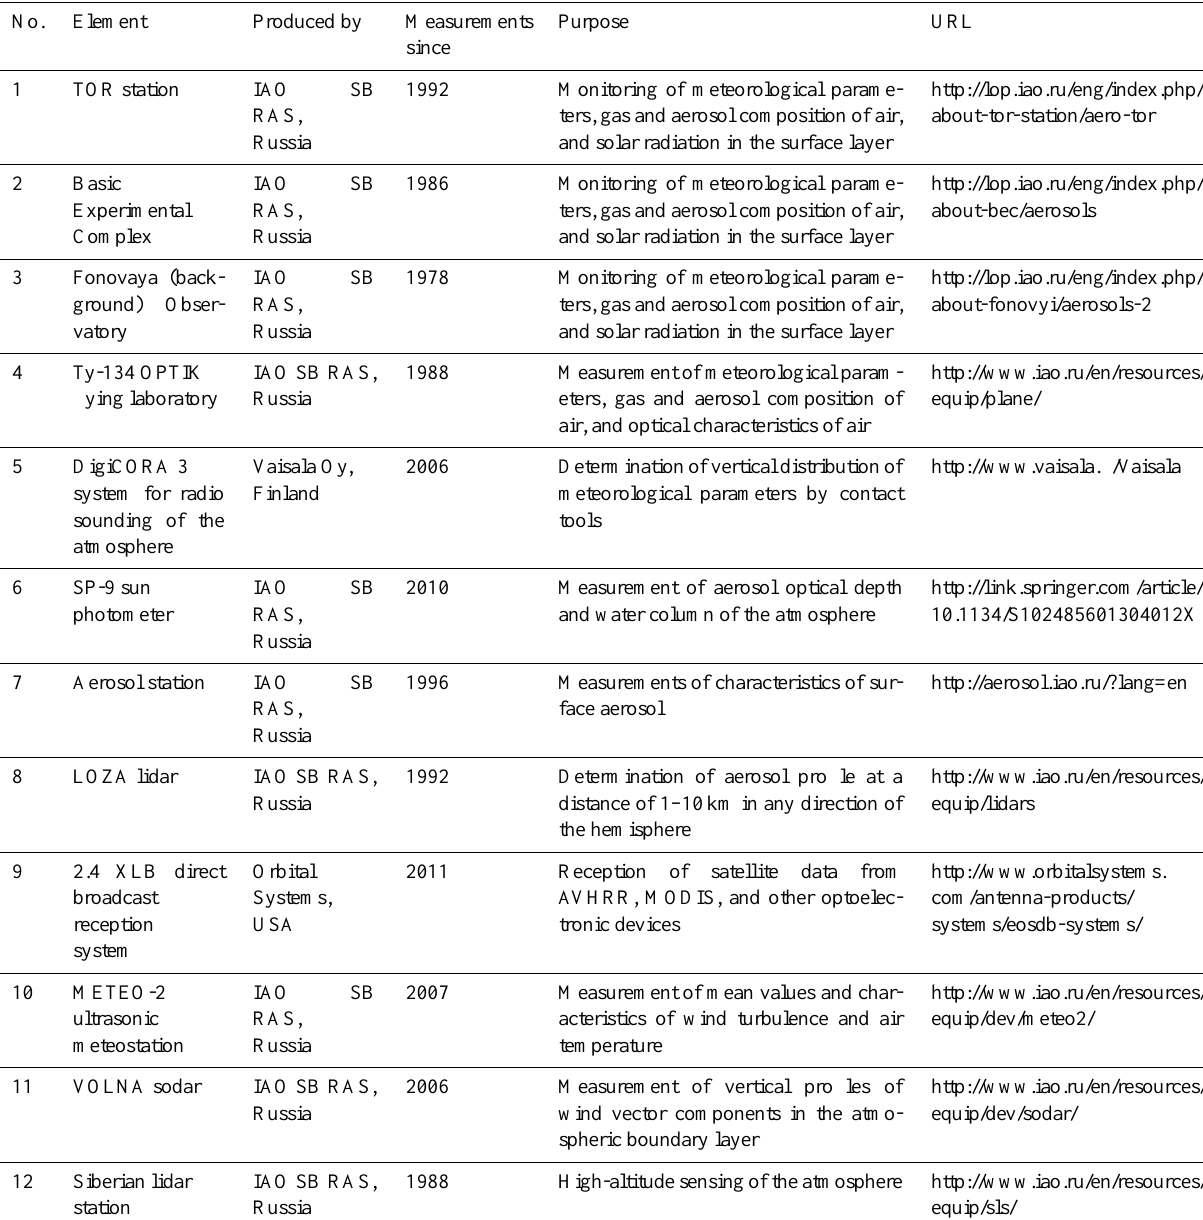
Table 1. Composition and purpose of individual elements of the measurement system. No.